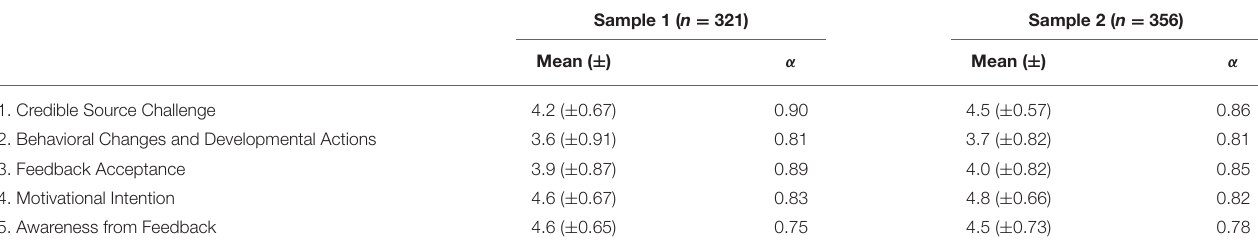
TABLE 3 | Descriptive statistics (where values are means and standard deviation ± ) and internal consistency (Cronbach’s alpha) for the